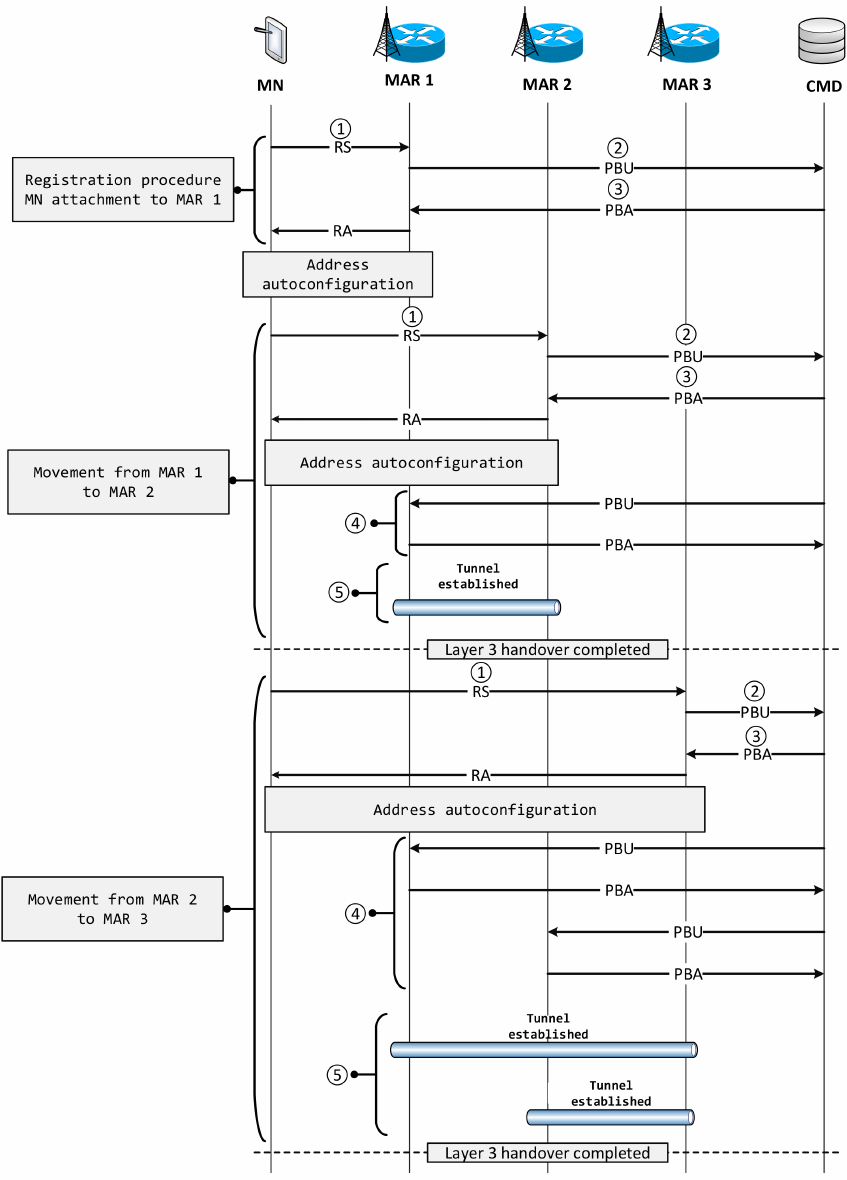
Figure 3. Messages flow in